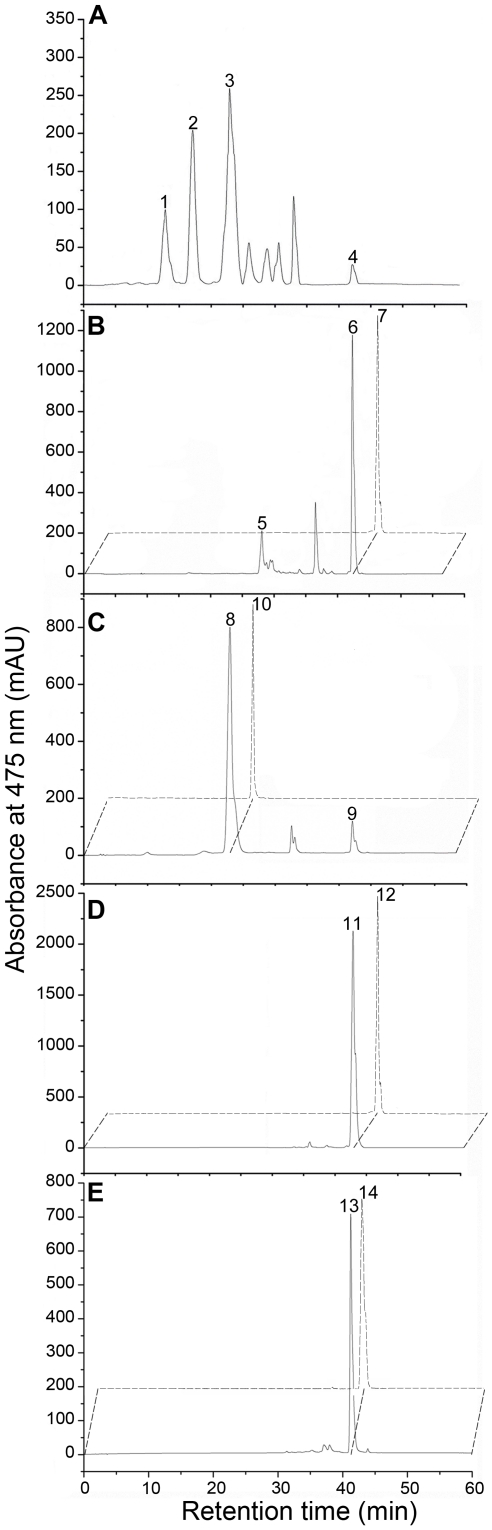
HPLC elution profiles of the pigments extracted from the wild-type and the knockout mutants.Solid lines, the wild-type and the knockout mutants; dashed lines, the control assays. A, wild-type; B, ΔcrtZ; C, ΔcrtG; D, ΔcrtZG; E, ΔcrtY. The major pigments were identified as nostoxanthin (peak 1, λmax: 274, 450, 476; [M+H]+: 601), caloxanthin (peak 2, λmax: 276, 450, 476; [M+H]+: 585), zeaxanthin (peaks 3, 8 and 10, λmax: 275, 450, 476; [M+H]+: 569), 2,2′-dihydroxy-β-carotene (peak 5, λmax: 272, 450, 476; [M+H]+: 569), β-carotene (peaks 4, 6, 7, 9,11 and 12, λmax:452, 476; [M+H]+: 537) and lycopene (peak 13 and 14, λmax:296, 362, 446, 470, 502; [M+H]+: 537).